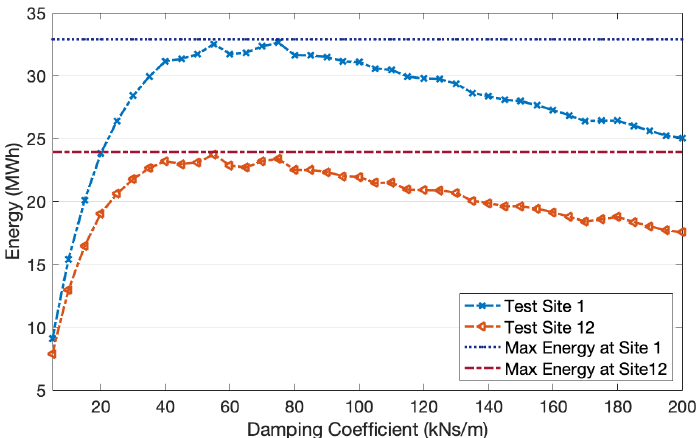
Figure 21. Overall annual energy production under constant damping control by varying the damping coefficient from 5 kNs/m to 200 kNs/m with an interval of 5 kNs/m. In Figure 21, two profiles shared some similarities with the results in Figure 10.